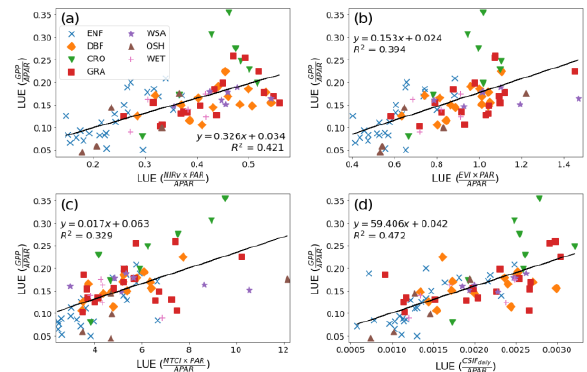
Figure 7. Relationships between LUE based on GPP-EC and LUE based on different PEMs during peak growing seasons across flux tower sites.